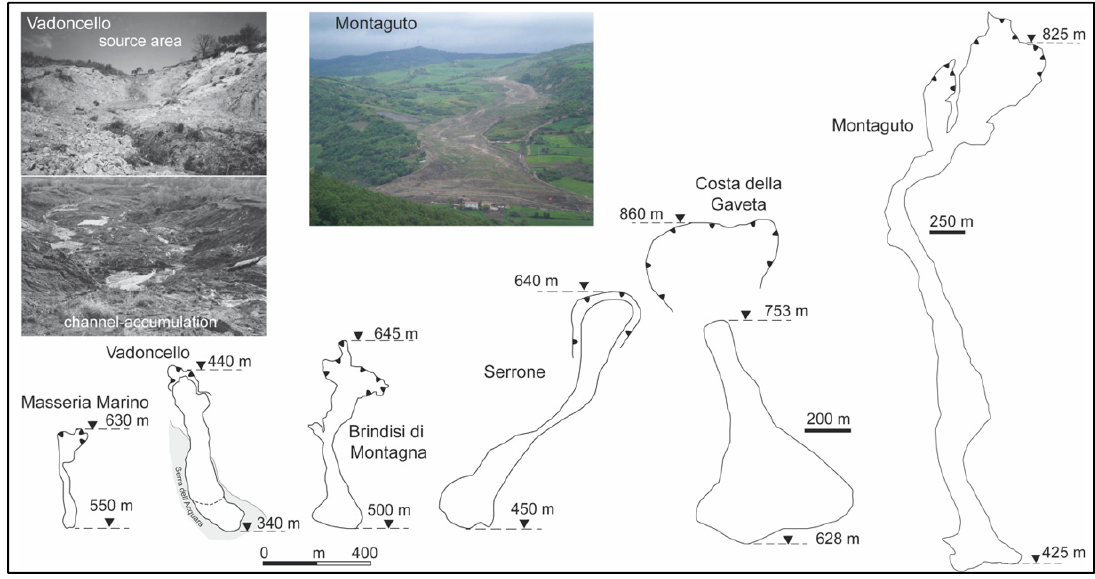
Figure 16. Some earthflows/mudslides (class 4; Figure 11 and Table 6; modified from